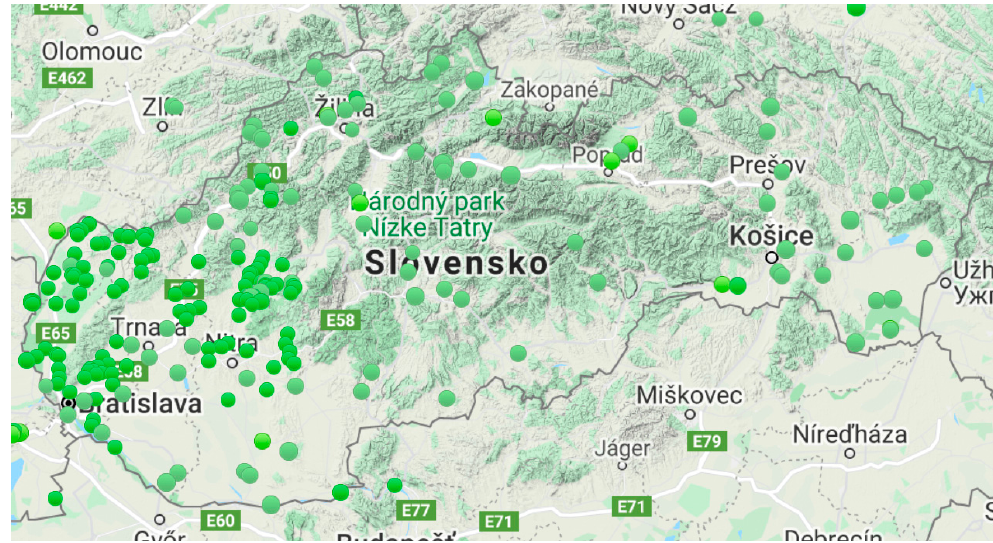
Figure 32. Location of biogas and biomass power plants of Slovak Republic [24].